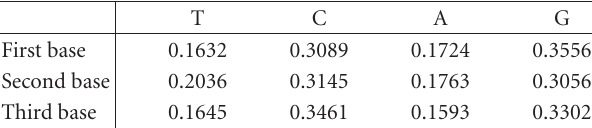
Table 3: Fractions of nucleotides at the three base sites of a codon in the coding sequence of Mycobacterium tuberculosis